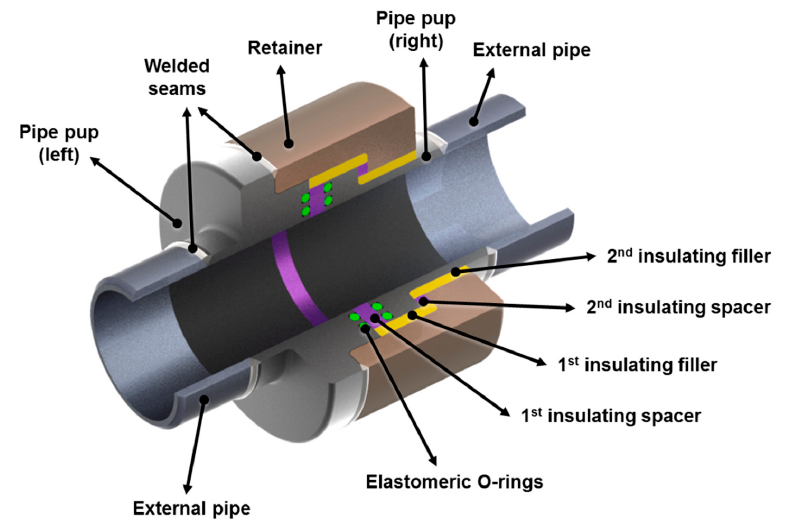
Figure 1. Example of insulating joint with a double-O-ring sealing system.